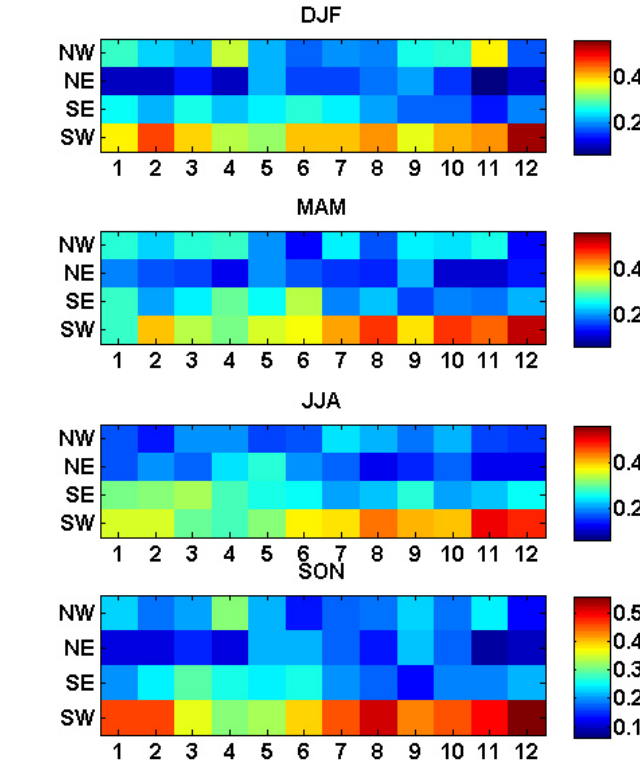
Figure 10. Relative contribution of wind direction to the average daily precipitation rate at each of 12 radar stations during four sea- sons. Wind directions are abbreviated as NW (northwesterly), NE (northeasterly), SE (southeasterly) and SW (southwesterly).